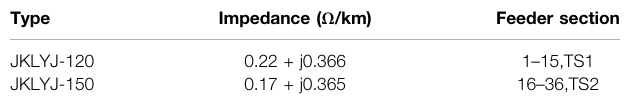
TABLE 5 | Wire types and parameters of Bus 2